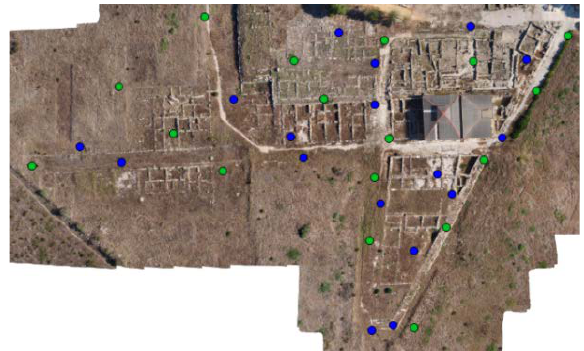
Figure 8. GCP (in green) and CP (in blue) layout on the area of interest.